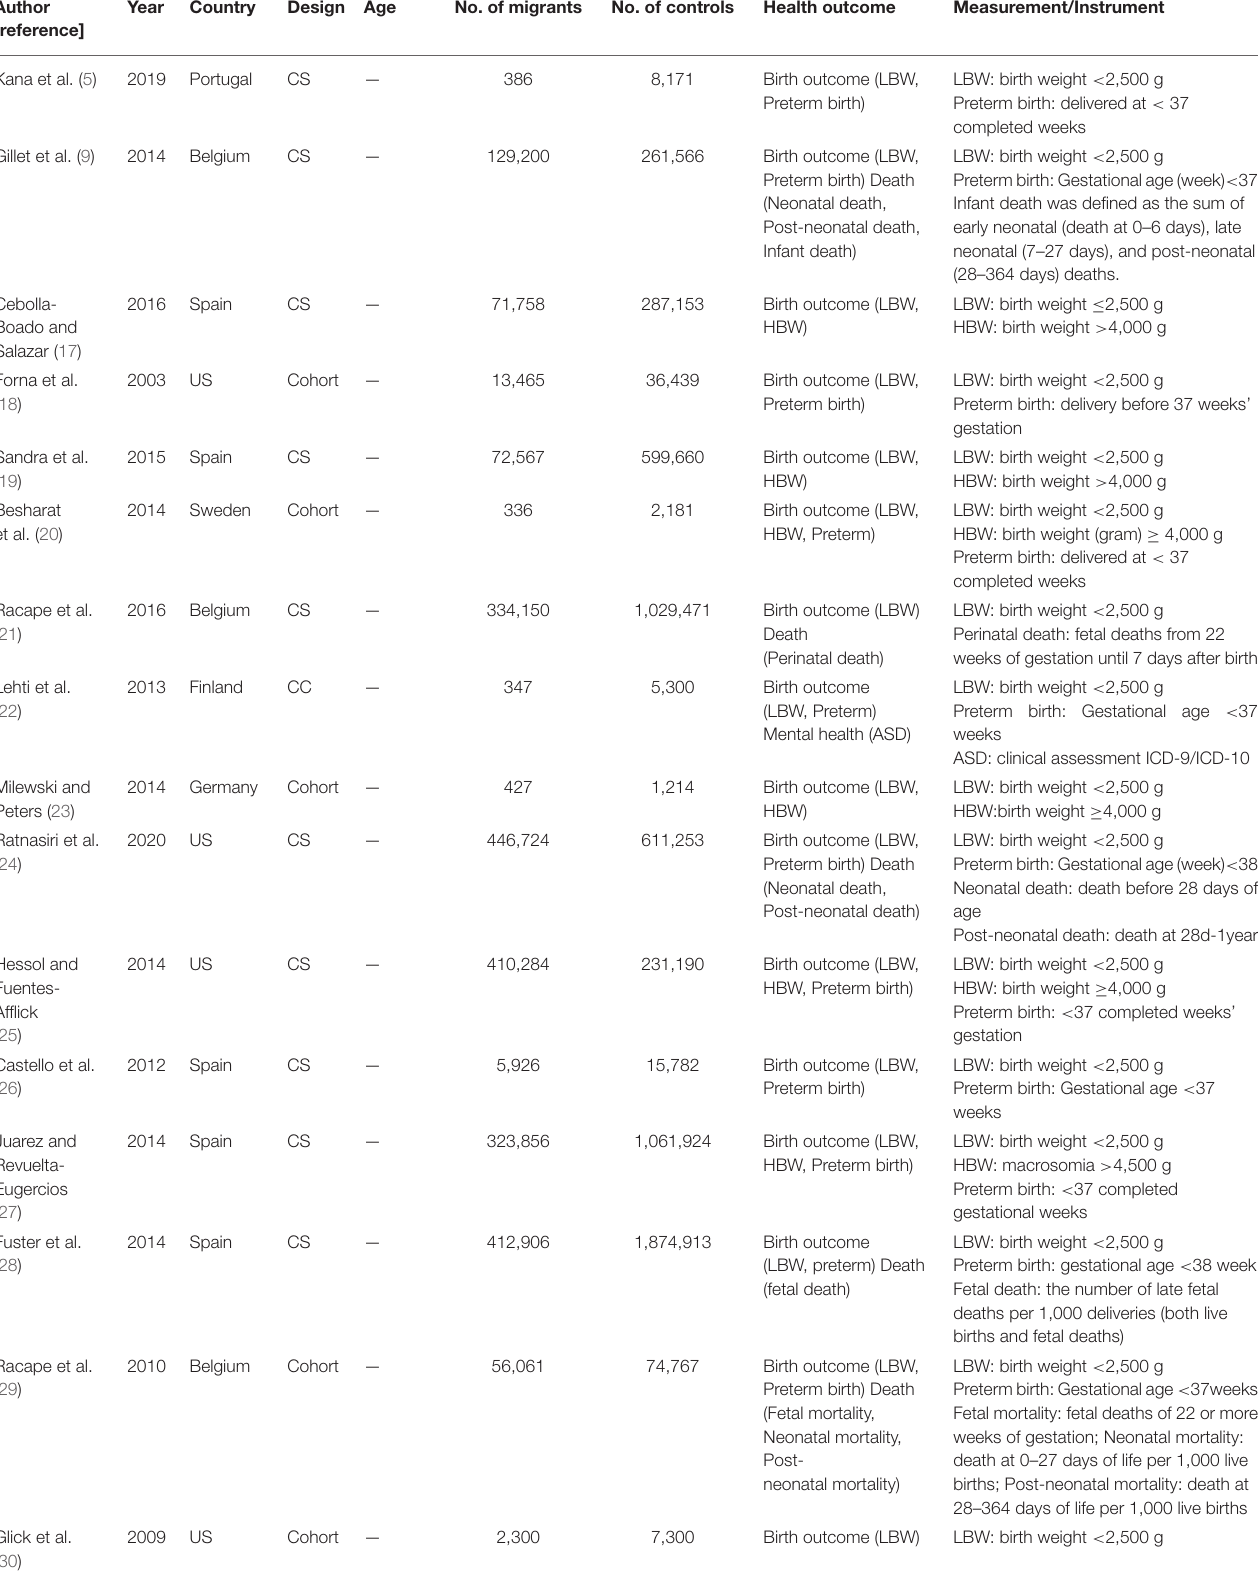
TABLE 1 | Characteristics of the included studies ( N =